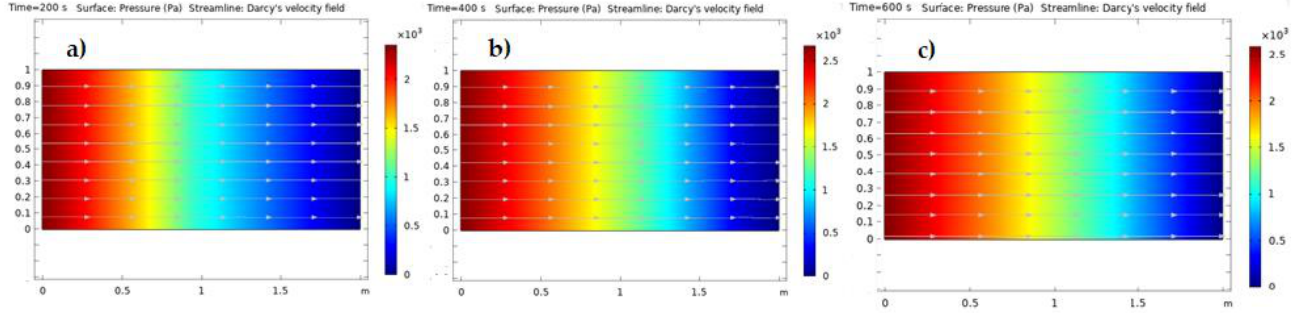
Figure 9. ( a ) Pressure distribution inside the porous medium at 200 s, ( b ) pressure distribution inside the porous medium at 400 s, and ( c ) pressure distribution inside the porous medium at 600 s.